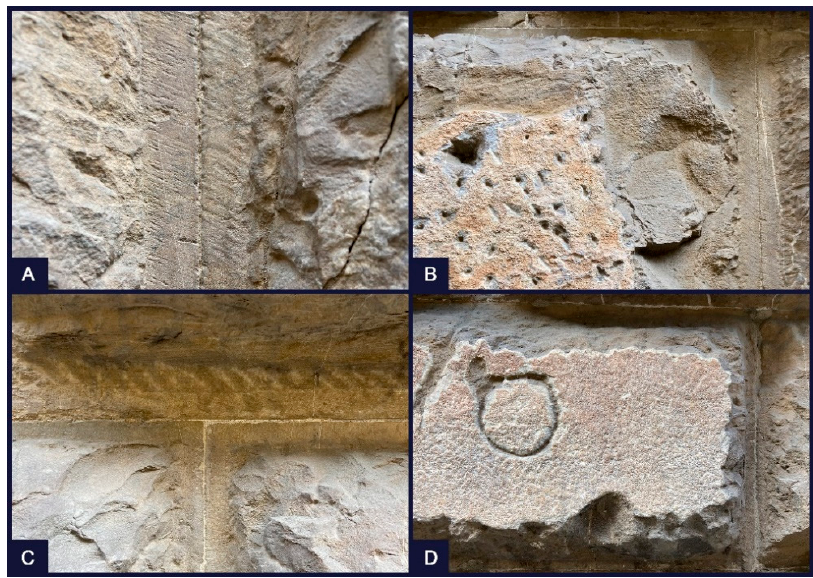
Figure 5. Different types of joints between blocks and finishes: ( A ) vertical joint with traces of chisel; ( B ) corner joint with traces of subbia ; ( C ) joint between three blocks with traces of subbia ; and ( D ) ashlar with trace of the stonemason.